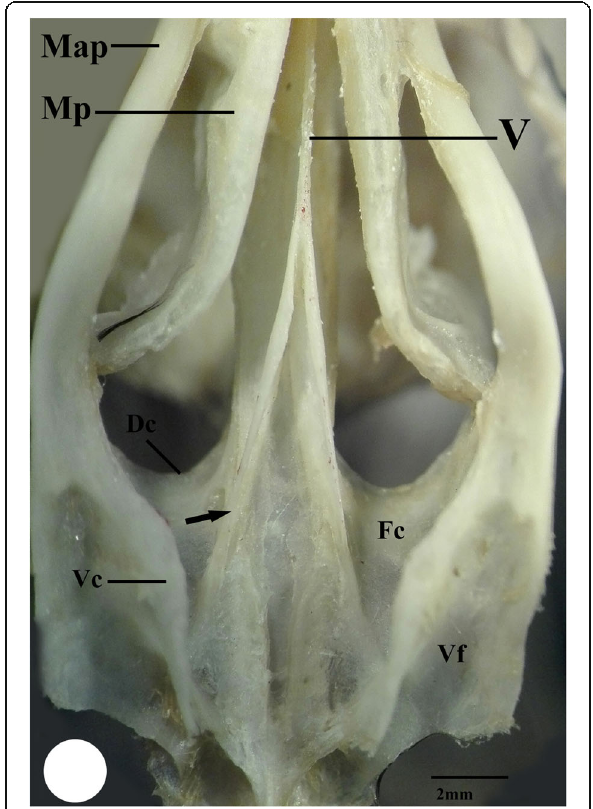
Fig. 7 High magnification of ventral surface of skull of common moorhen shows the maxillary process of the palatine bone (Map), maxillopalatine process (MP), vomer bone (V), choana fossa (Fc), medial crest (arrow), ventral crest (Vc), and ventral fossa (Vf)